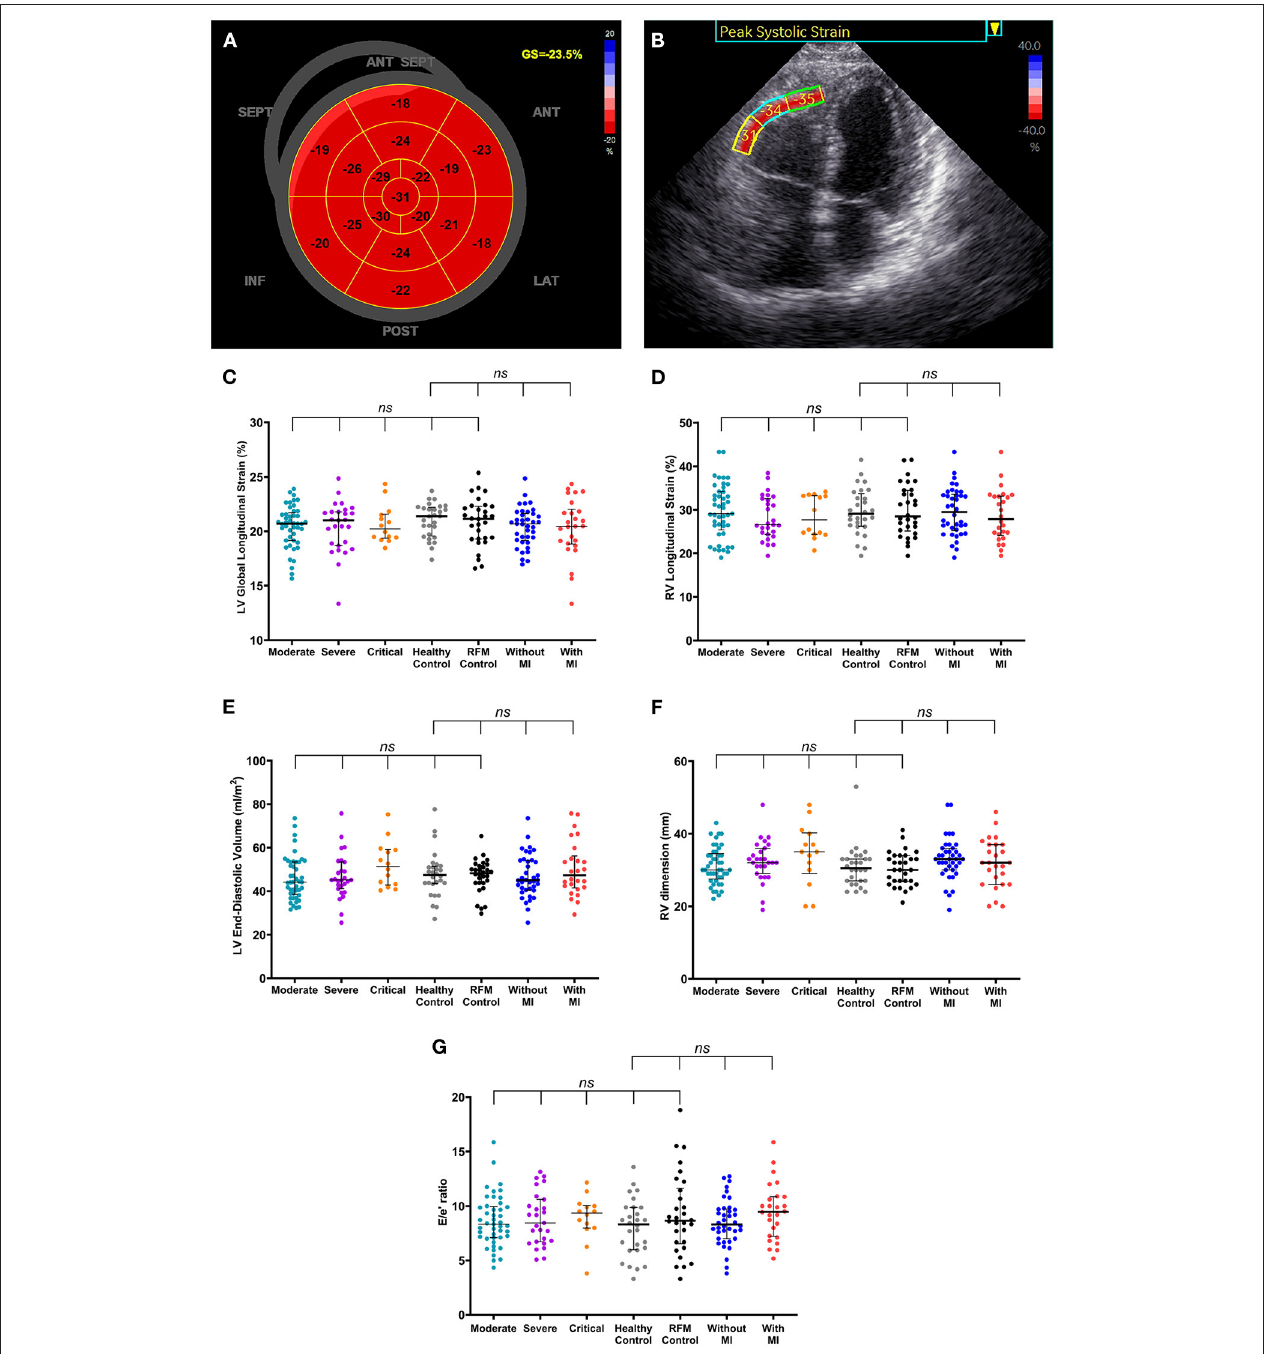
FIGURE 1 | Normalized cardiac structure and function in coronavirus disease 2019 (COVID-19) survivors late after the recovery. (A,B) A patient (75–80 years old) with no history of hypertension, diabetes, and/or coronary heart disease was diagnosed with severe-type COVID-19 illness. High-sensitivity troponin I level was 1,137 pg/ml at admission and 4.3 pg/ml on the day of echocardiographic examination (316 days after COVID-19 diagnosis). (A) Shows normal left ventricular (LV) global longitudinal strain (GS) and panel B shows normal right ventricular (RV) free wall longitudinal strain for basal, mid, and apical segments. (C–G) There were no significant differences in LV global longitudinal strain (C) , RV longitudinal strain (D) , LV end-diastolic volume (E) , RV dimension (F) , and the ratio of peak early velocity in mitral inflow to peak early diastolic velocity in the septal mitral annulus [E/e’, (G) ] among groups classified according to disease severity and the presence of myocardial injury at admission, healthy control, and risk-matched control. Longer black lines indicate the medians and shorter black lines indicate the interquartile ranges. Each dot represents a value. ANT, anterior; LAT, lateral; POST, posterior; INF, inferior; SEPT, septum; ANT SEPT, anterior septum; RFM, risk-factor matched; MI, myocardial injury; LV, left ventricular; RV, right ventricular.